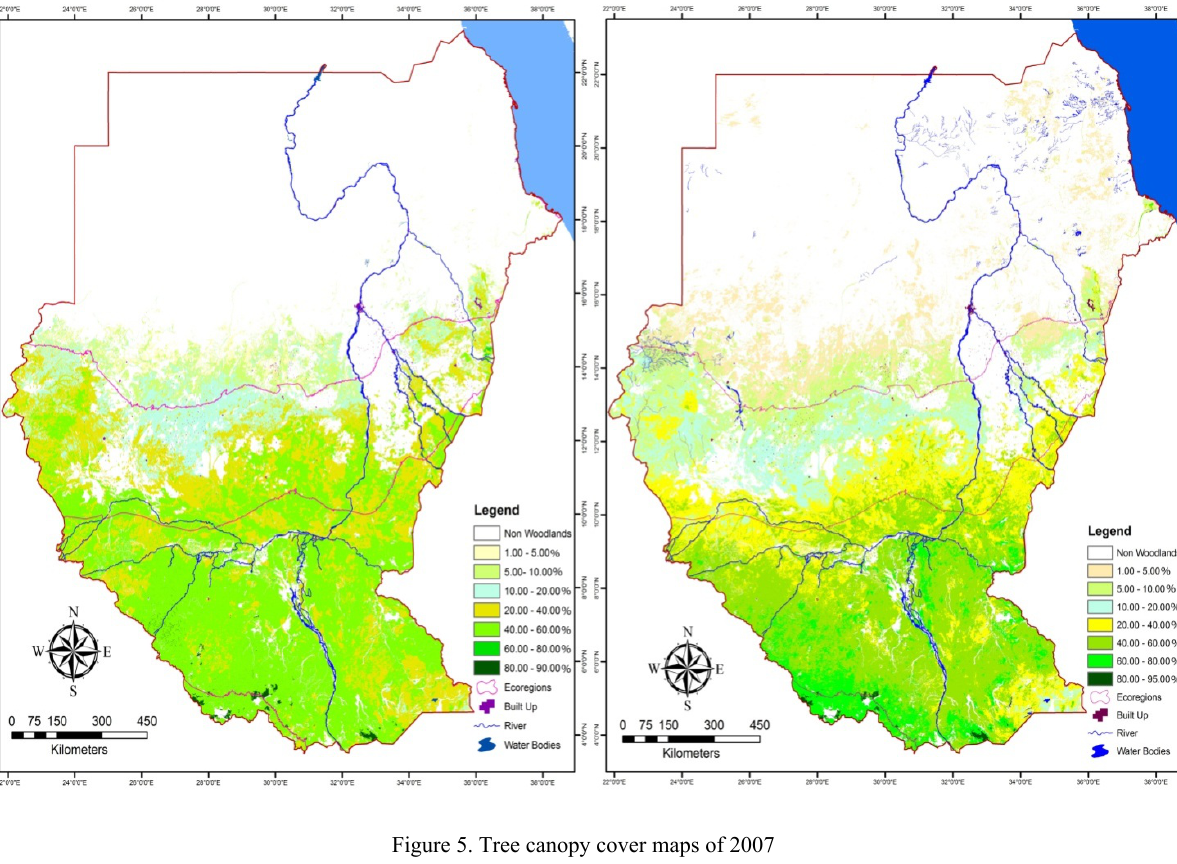
Figure 5. Tree canopy cover maps of 2007 (left: summer and right: